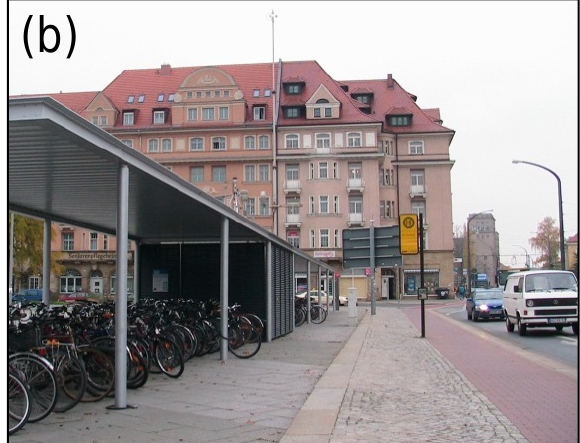
Site 4: Dresden-Nord (roadside)